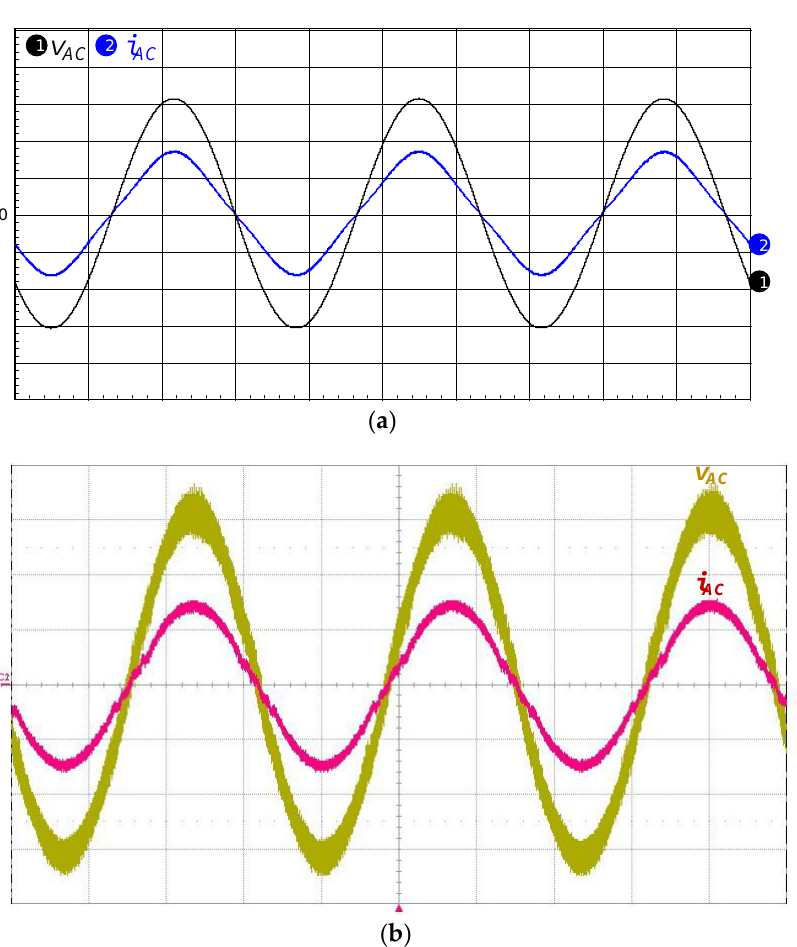
Figure 20. ( a ) Simulated and ( b ) measured input utility-line voltage v AC (50 V/div) and current i AC (1 A/div); time scale: 5 ms/div.